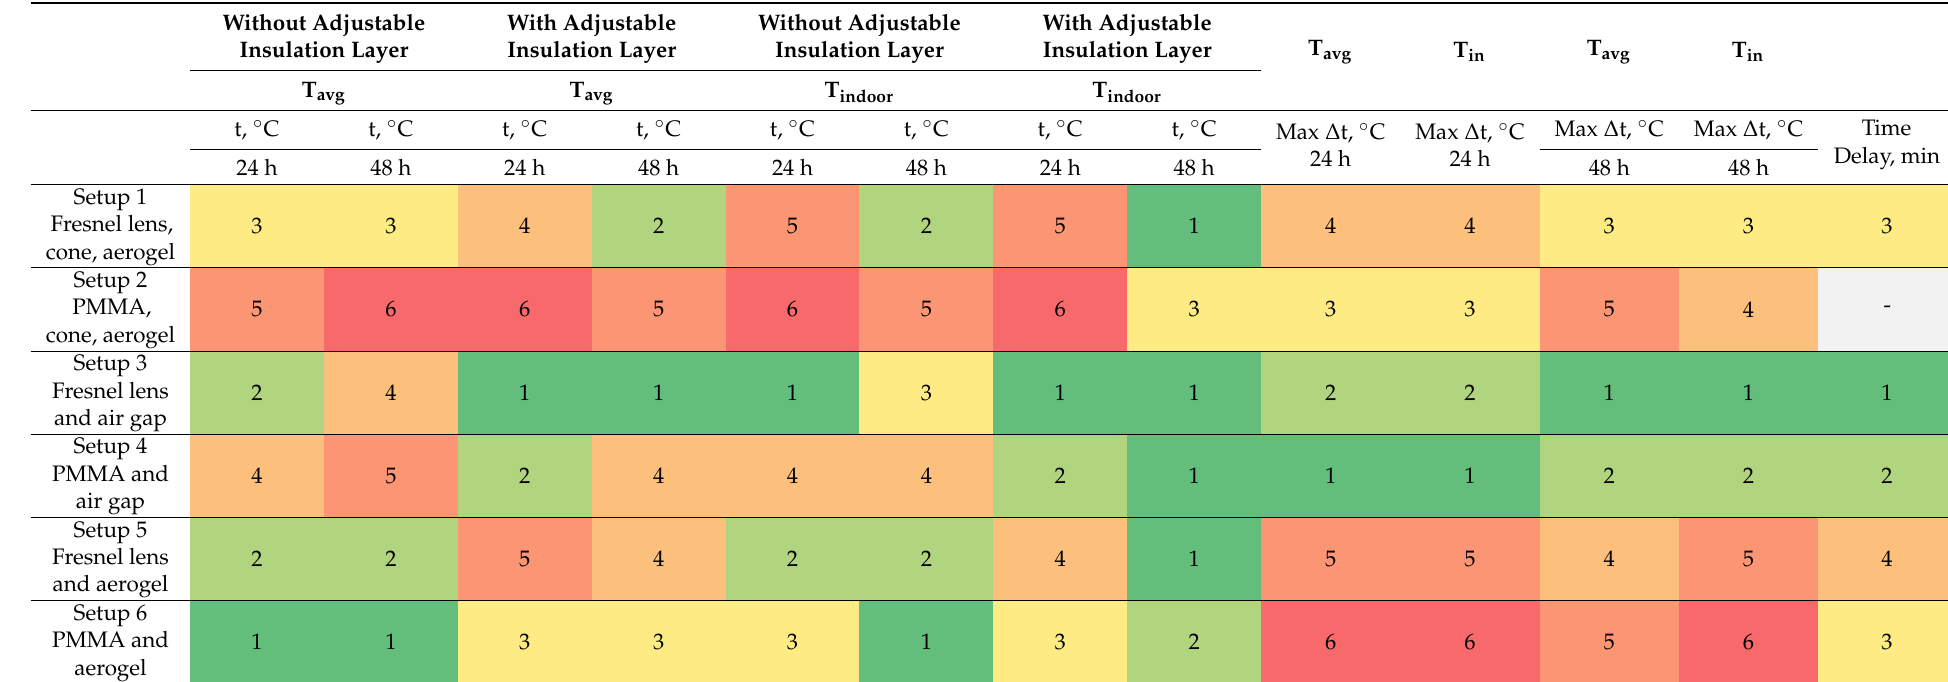
Table 7. Ranking of setups in defined points of